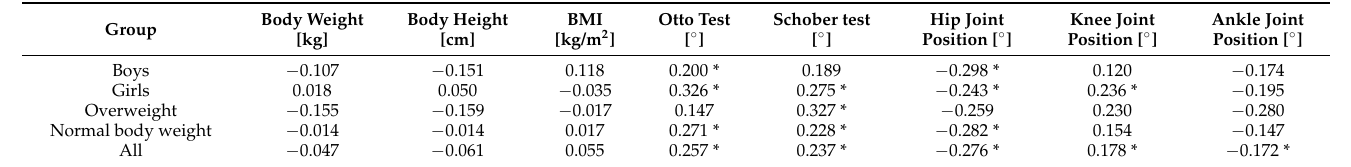
Table 6. Correlations between the stand and reach test results and the studied variables in groups distinguished by gender and body weight